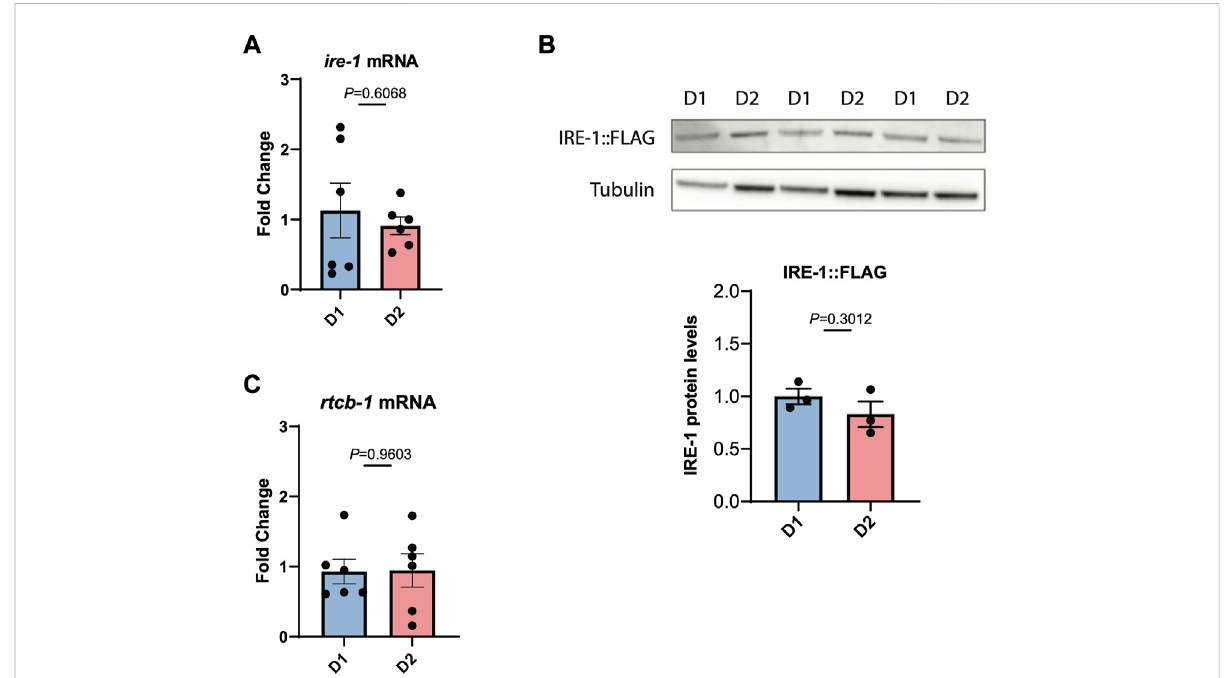
FIGURE 3 IRE-1 levels are not decreased during the fi rst day of adulthood as animals enter the reproductive period. (A) The levels of ire-1 mRNA were measuredbyqRT-PCRinanimalsatthebeginningofDay1(D1)andDay2(D2)ofadulthood. (B) ThelevelsofendogenouslytaggedIRE-1-FLAGwere monitored in animals by Western blotting with an α -FLAG antibody at the beginning of Day 1 (D1)and Day 2 (D2) of adulthood. Band intensities were quanti fi ed using ImageJ and normalized to tubulin control bands. (C) The levels of rtcb-1 mRNA were measured by qRT-PCR in animals at the beginning of Day 1 (D1) and Day 2 (D2) of adulthood. Signi fi cance in each panel was assessed by Unpaired t